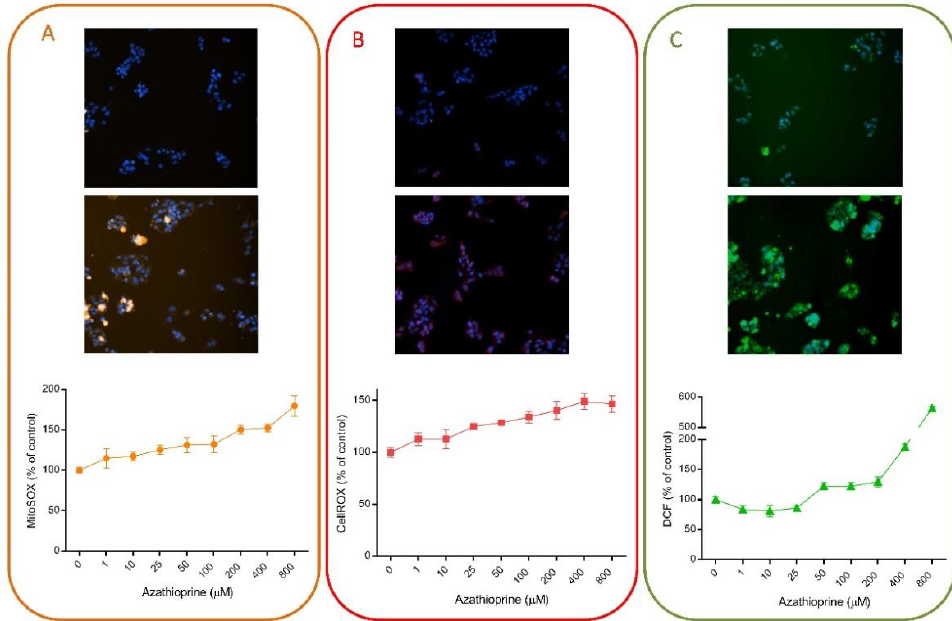
Figure 3. Azathioprine induces oxidative stress in liver cells. HepG2 cells were exposed to a range of concentrations of azathioprine (1–800 µ M) for 1 h and then, incubated with MitoSOX Red ( A ), CellROX Deep Red ( B ) or DCF ( C ) and were analyzed using HCS. On the top of each panel, non-treated cells are shown, in contrast to cells treated with 400 µ M of azathioprine, which are shown in the bottom part. HCS technology allows the quantification of changes induced by drugs and shows its utility for toxicological studies and to determine the major mechanisms implicated in their